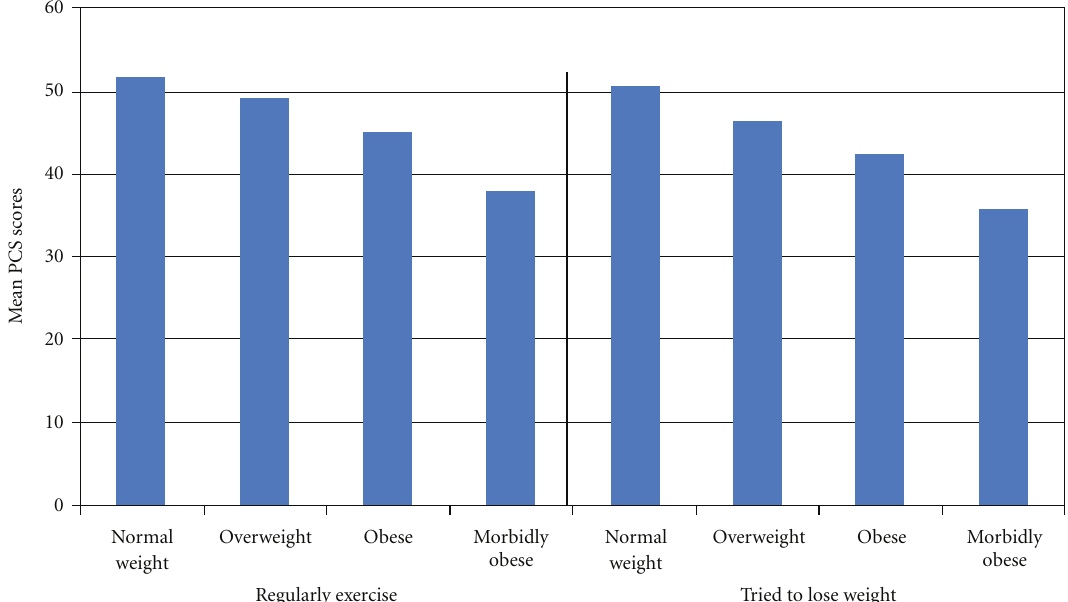
Figure 1: Mean Physical Component Summary scores for SHIELD respondents who reported exercising regularly or trying to lose weight by weight category. ANOVA P < . 001; normal weight = body mass index (BMI) < 25.0 kg/m 2 ; overweight = BMI between 25.0 and 29.9 kg/m 2 ; obese = BMI between 30.0 and 39.9 kg/m 2 ; morbidly obese = BMI ≥ 40kg/m 2